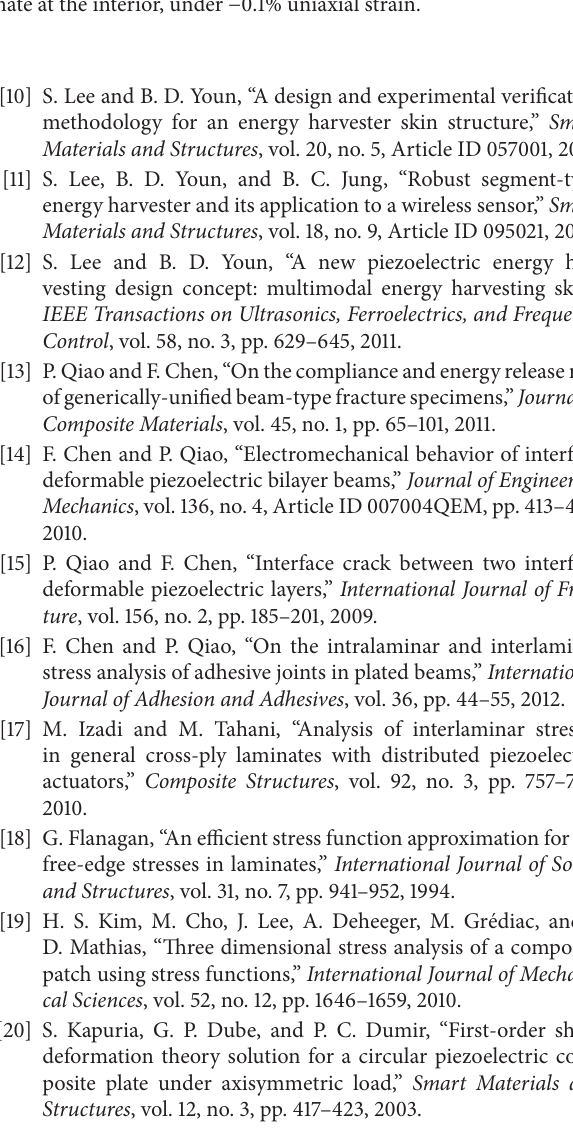
Figure 12: 𝜎 2 distribution of [PZT/45 4 / − 45 4 ]s laminate at the interior, under − 0.1% uniaxial